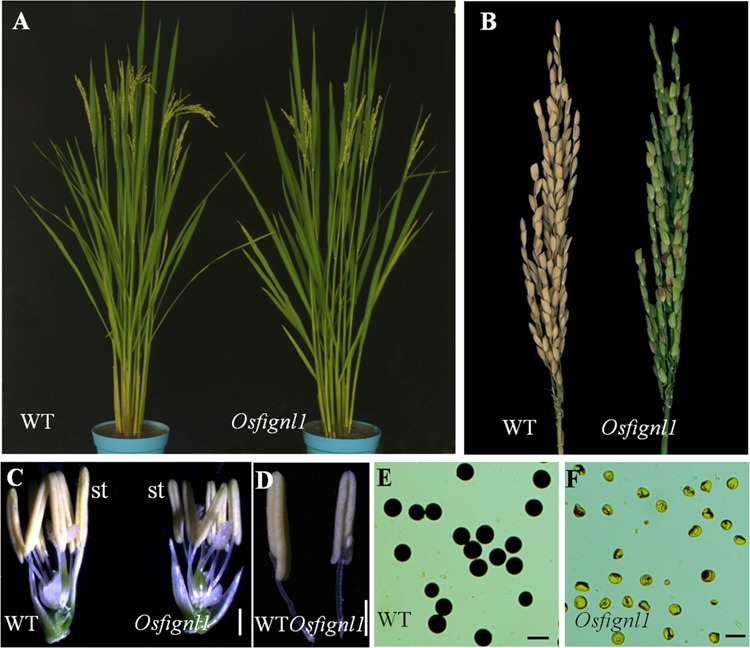
Phenotype comparisons between the wild-type (WT) and the Osfignl1 mutant. (A) Comparison between a WT (left) and a Osfignl1 mutant (right) plant after heading. (B) Comparison of a WT panicle (left) and a Osfignl1 mutant panicle (right) at the harvest stage. (C) Comparison of a WT (left) and the Osfignl1 mutant spikelet (right) after removal of palea and lemma. (D) Comparison of a WT (left) and a Osfignl1 mutant anther (right). (E) I2-KI staining of WT pollen grains. (F) I2-KI staining of Osfignl1 mutant pollen grains. st, stamen. Bars = 1 mm in (C,D), 50 μm in (E,F).